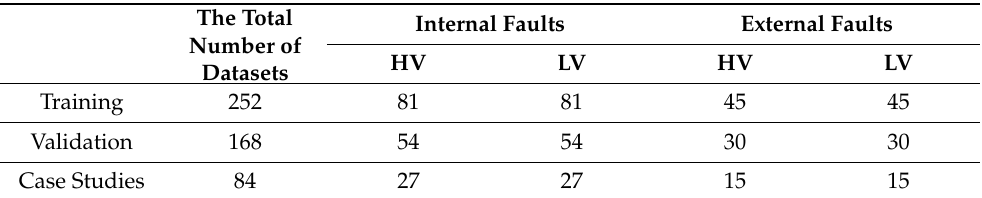
Table 2. The total number of PNN datasets.